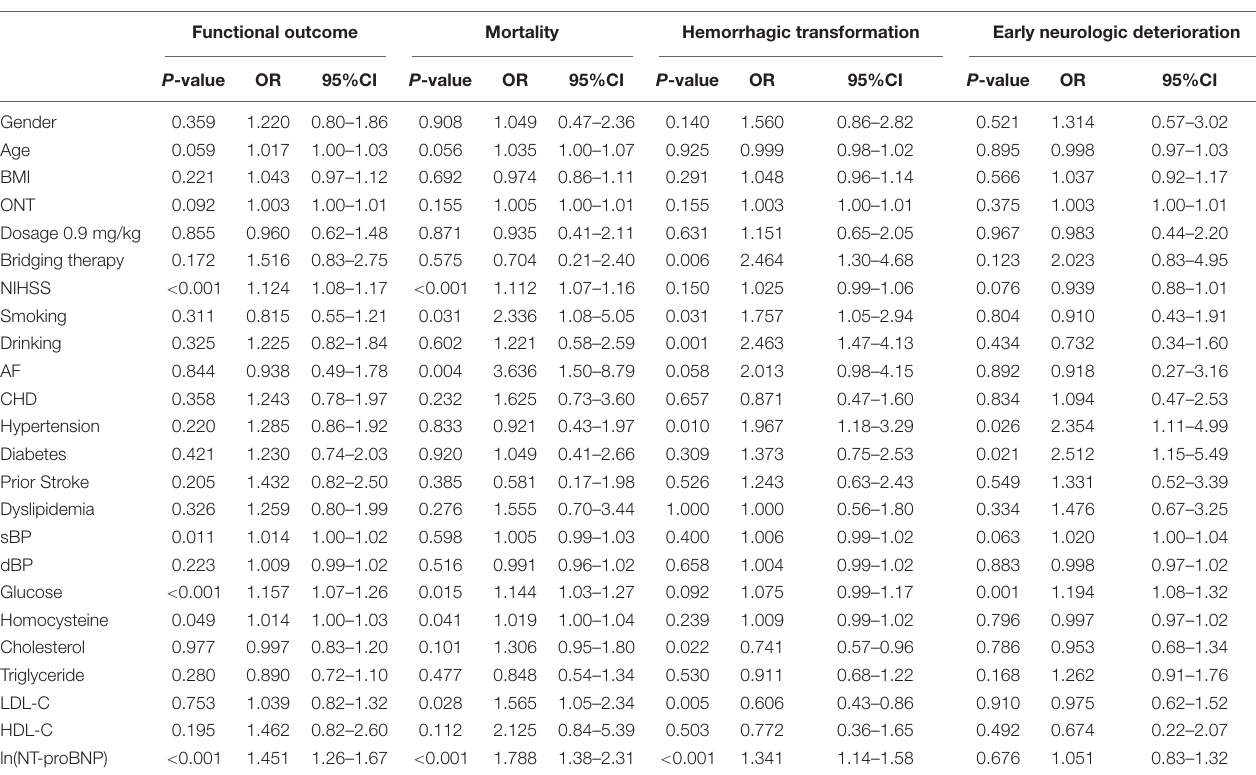
TABLE 2 | Results of univariate analysis.